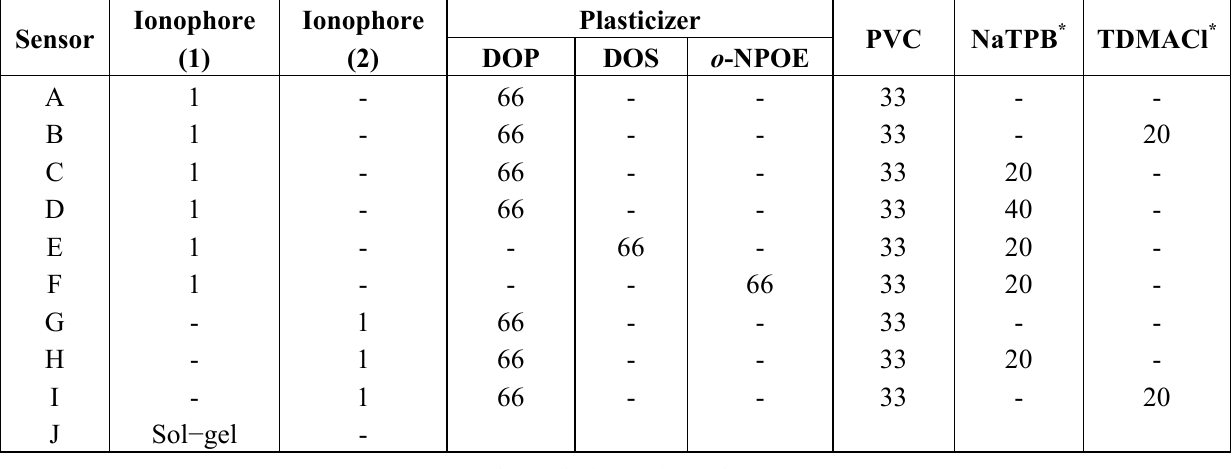
Table 1. Membrane composition (% w/w) of the diclofenac–selective sensors.